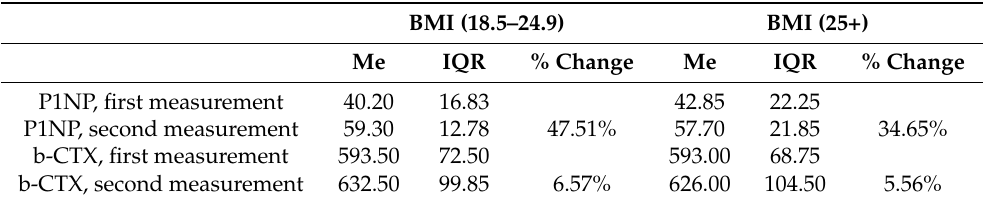
Table 3. BMI and improvements in the P1NP and b-CTX values.